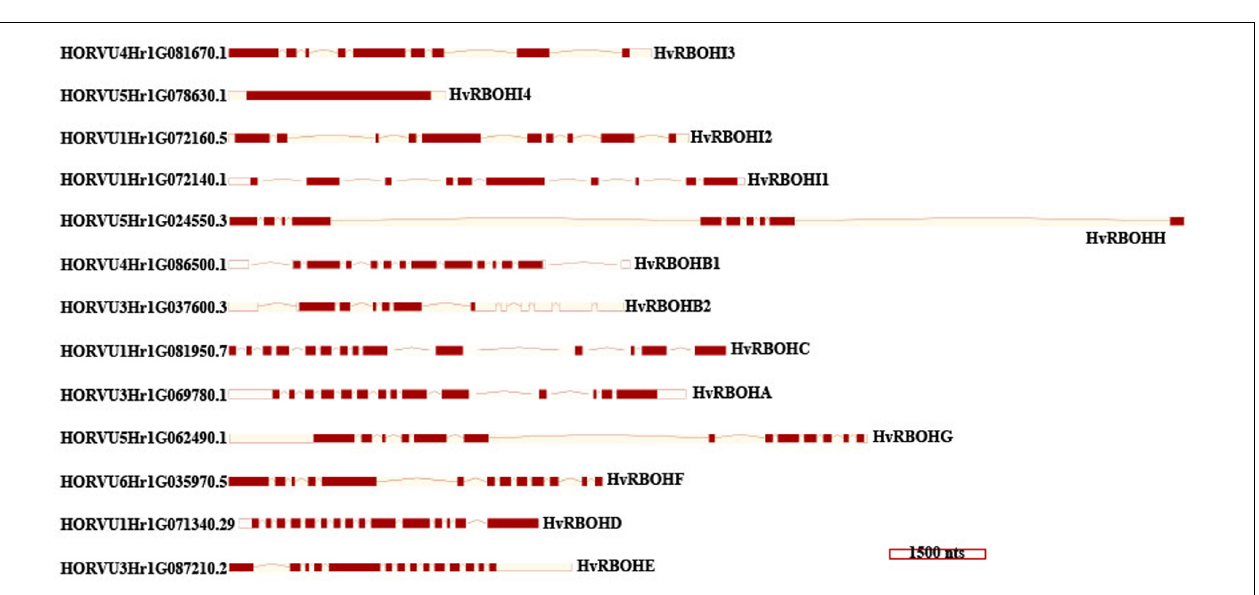
FIGURE 4 | HvRBOH gene models retrieved from the Ensembl database. Longest coding isoforms for each of the barley gene models are shown and their corresponding gene identifiers are on the left. The newly proposed gene names for the HvRBOH genes based on their groupings with the corresponding rice genes are shown on the right. The brown colored boxes represent the exons, the connecting lines represent the introns. The models are drawn to scale shown at the bottom and arranged to show the similarity with the phylogenetic groupings in Figure 3